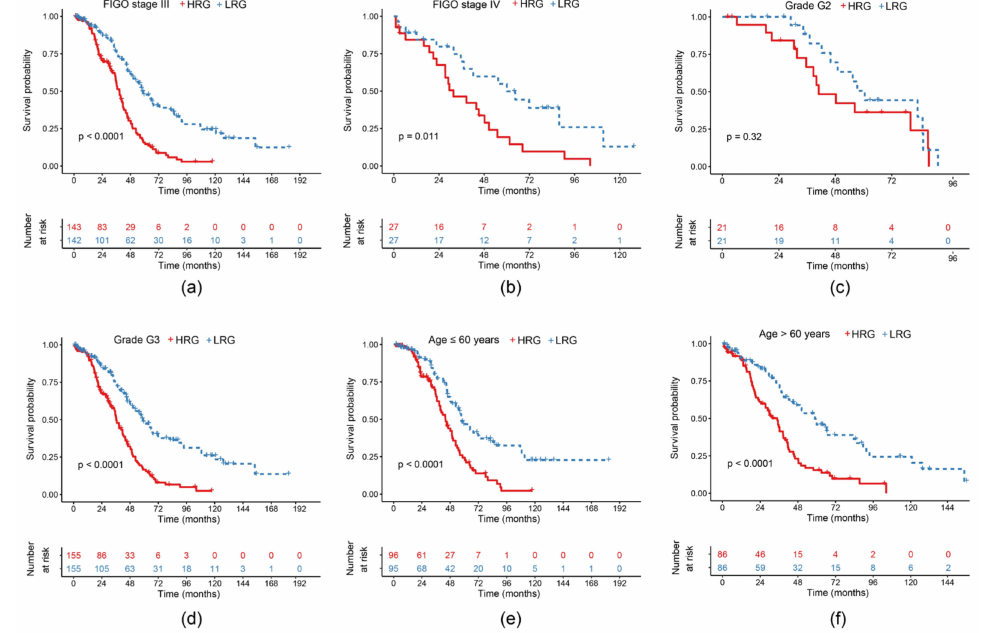
Figure 5. KM curves of overall survival (OS) of the 11-gene risk model in di ff erent clinical